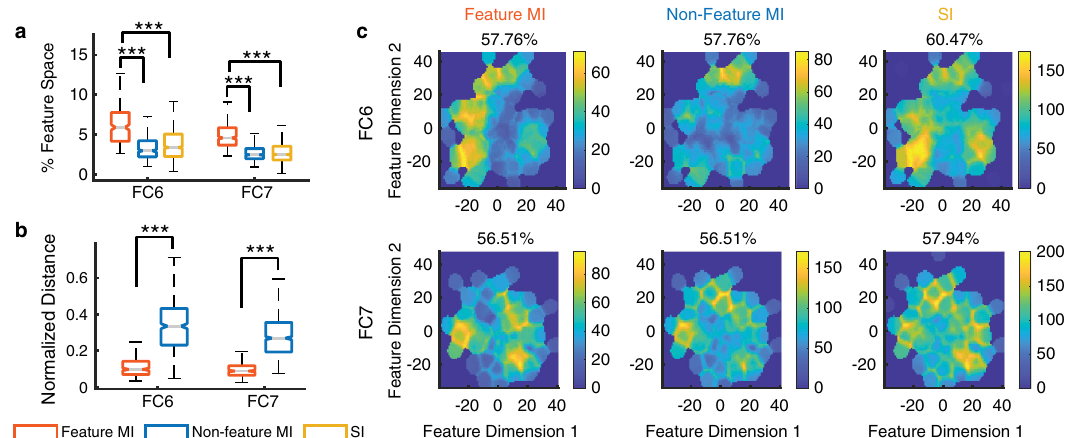
Fig. 8 Summary of region-based feature coding for SI and MI DNN units. a Percentage of feature space covered by tuning regions of SI and MI units. Note that here we did not apply the threshold for minimal cluster size for SI and non-feature MI units in order to compare between different types of units. b Normalized distance between MI unit ’ s selective identities in the feature space. To be comparable for different layers, Euclidean distance was normalized by the maximum distance (i.e., diagonal line) of the feature space. On each box, the central mark is the median, the edges of the box are the 25th and 75th percentiles, and the whiskers extend to the most extreme data points the algorithm considers to be not outliers. Asterisks indicate a signi fi cant difference between feature MI units and non-feature MI units using two-tailed unpaired t test. *** P < 0.001. c The aggregated tuning regions of the population of units. Color bars show the counts of overlap between individual tuning regions. The numbers above the density map show the percentage of feature space covered by the tuning regions of the population of